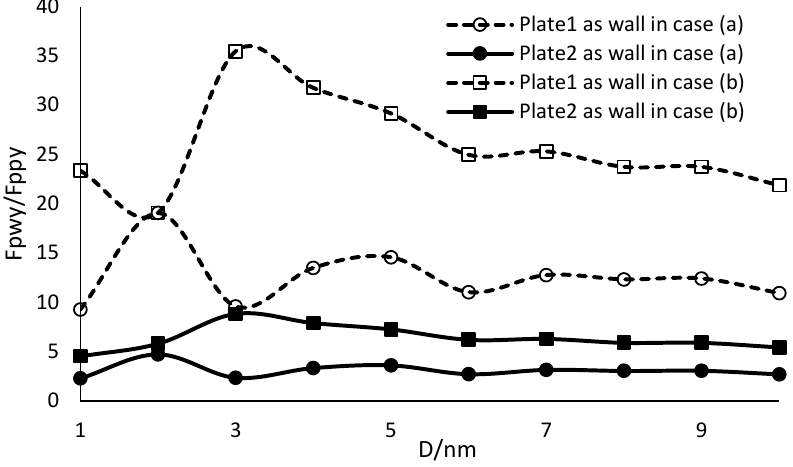
Figure 7. Comparison of the calculated forces with different choices of the ideal wall.